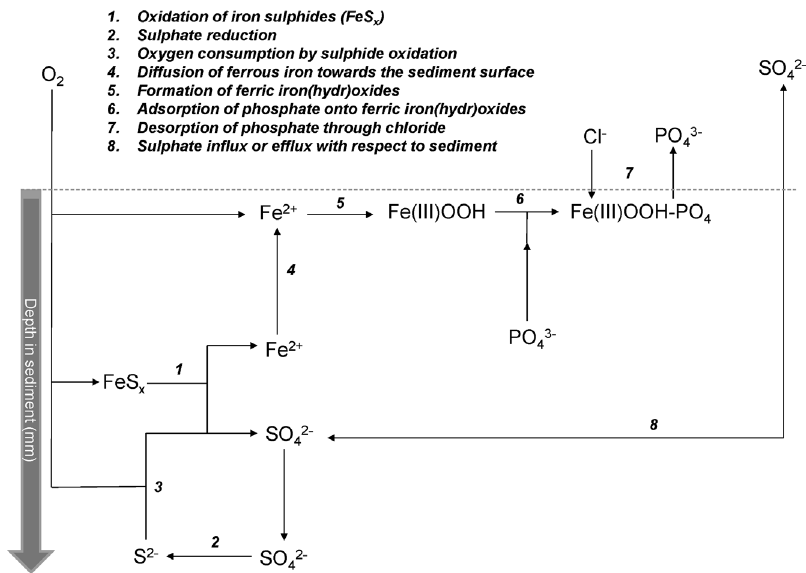
Figure 6. Schematic overview of the proposed mechanism, showing key processes in the upper millimetres of the S-rich, peat sediments involved in P mobilisation. Salinisation leads to an increased SO 42- influx, affecting Fe diffusion to the sediment surface, enabling increased P mobilisation in the longer term.